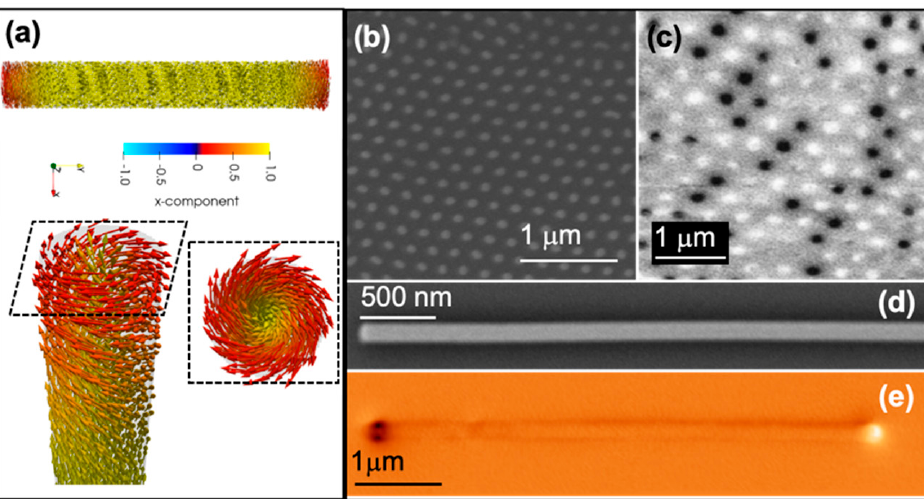
Figure 5. ( a ) Micromagnetic simulation of an individual FeCo nanowire presenting a longitudinal magnetization with vortices at the ends (top panel). Close-up images of the vortex structures are presented in the bottom panel, ( b ) SEM top view image of alumina template filled by magnetic nanowires, ( c ) Magnetic Force Microscopy (MFM) image of Ni nanowires embedded into the template (Reprinted with permission from ref. [49]. Copyright 2007 American Physical Society), ( d ) SEM image of a single CoNi nanowire, ( e ) MFM image of Co 35 Ni 65